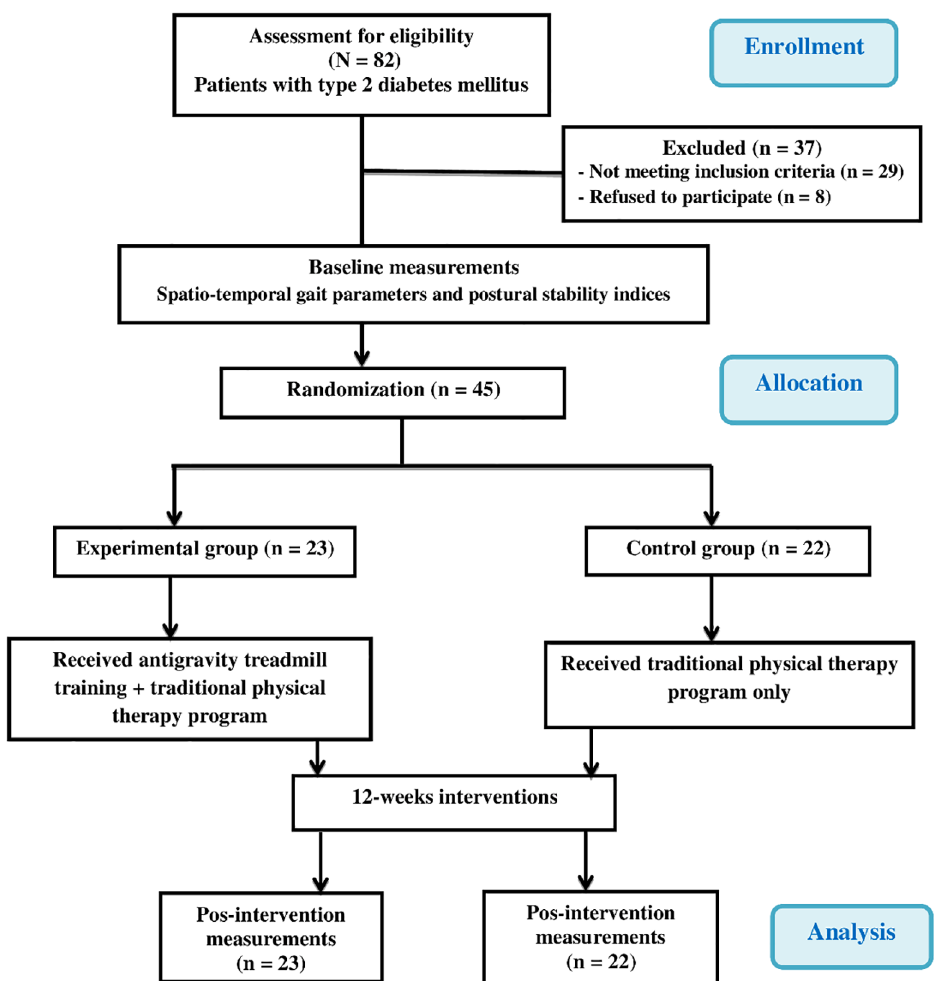
Figure 1. Flow chart showing the experimental design of the